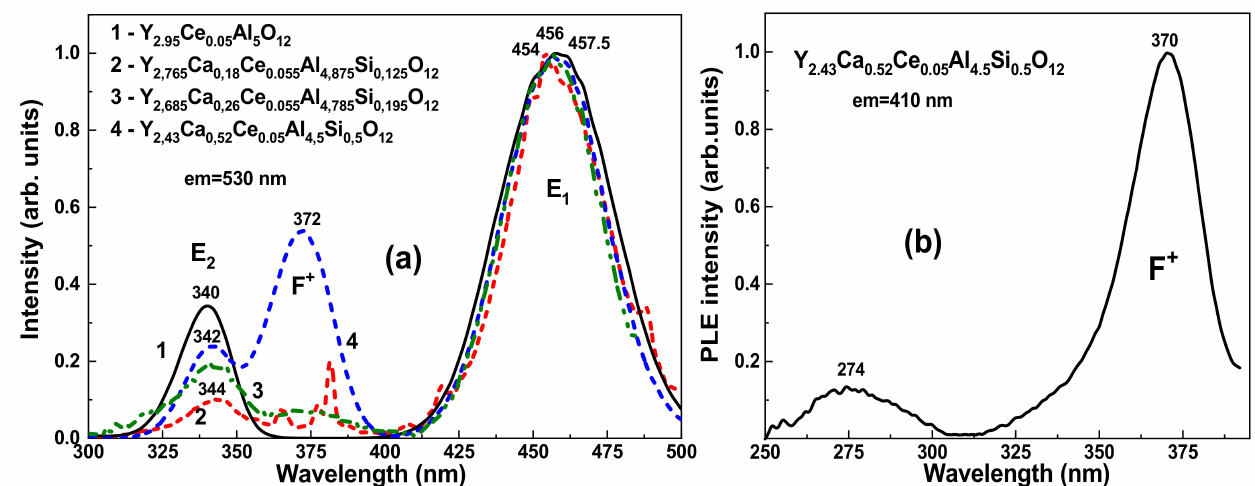
Figure 7. ( a )—RT excitation spectra of Ce 3+ luminescence at 530 nm in Y 3 − x Ca x Al 5 − y Si y O 12 :Ce SCFs with different Ca and Si content (2–4) in comparison with respective excitation spectra in YAG:Ce SCF (1). ( b )—RT excitation spectra of F + center luminescence in Y 2.43 Ca 0.52 Ce 0.05 Al 4.5 Si 0.5 O 12 SCF at registration of emission at 400